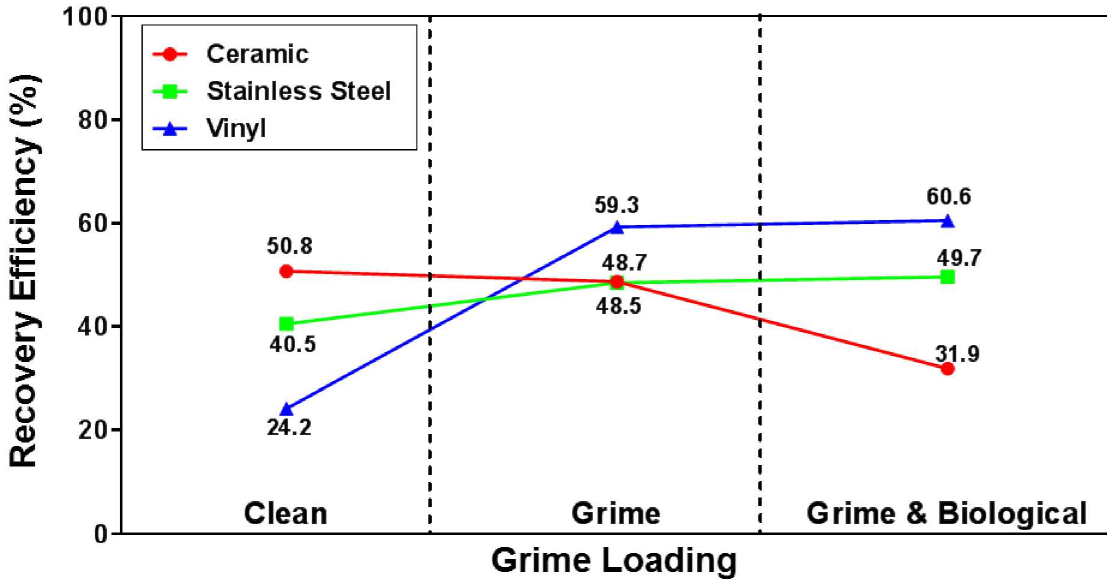
Fig 8. Grime coating on coupons is associated with an increased RE for stainless steel and vinyl coupons, but RE is reduced when grime is present on ceramic coupons. The presence of grime is an independent significant factor on RE. The interaction between material type and grime presence is also significant for